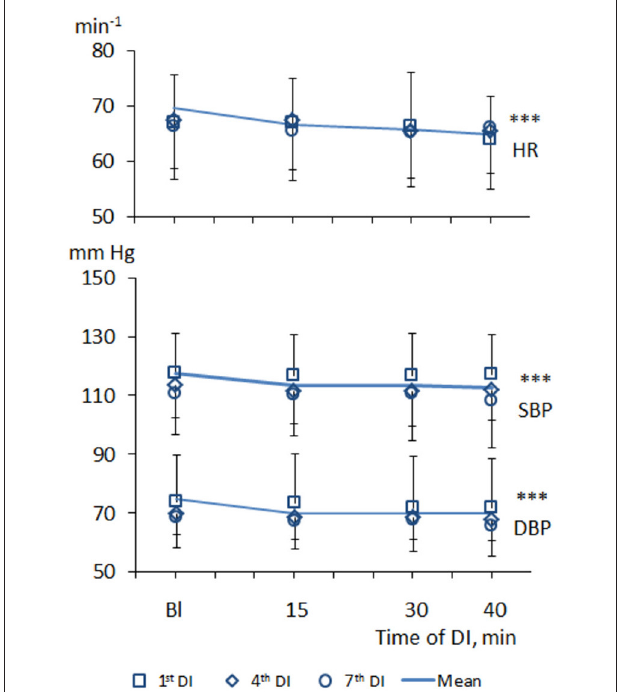
FIGURE 1 | Dynamics of heart rate and blood pressure in PD patients during repeated “dry” immersion sessions. HR, heart rate; SBP, systolic blood pressure; DBP, diastolic blood pressure. The blue line represents the mean of tree studied DI sessions. The difference from the baseline condition *** p < 0.001 (Friedman